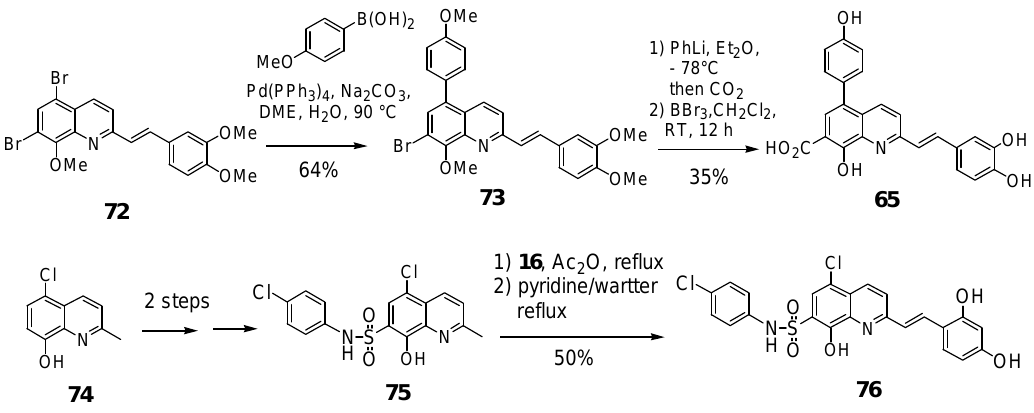
Scheme 8. Synthesis of 5-arylstyrylquinoline 65 and 7-sulfonamide 76 .